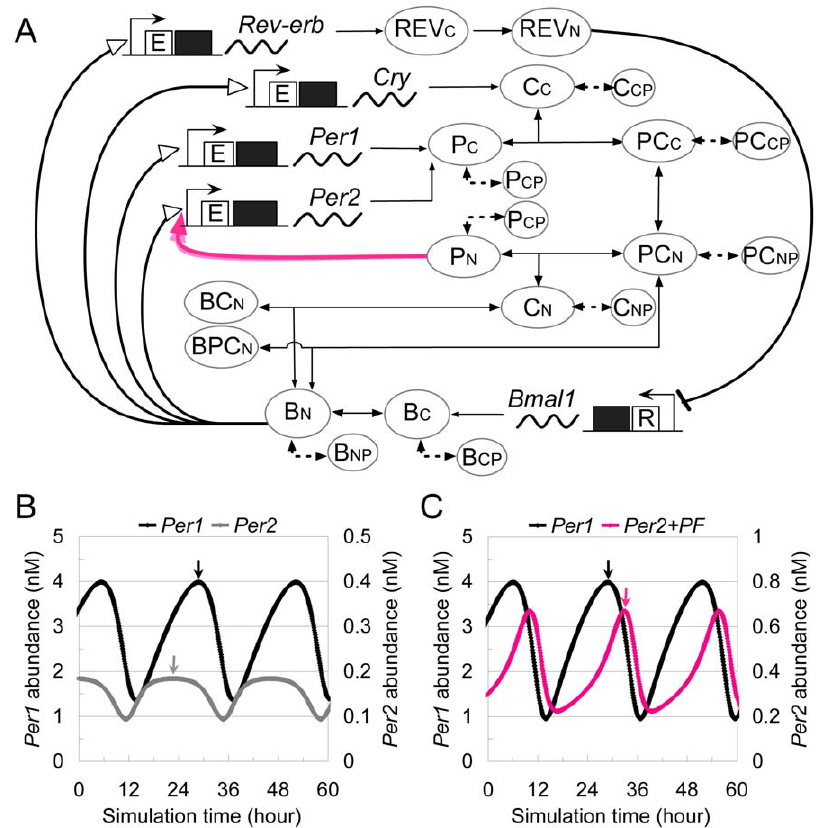
Figure 4. A novel model to reproduce the expression phase difference between Per1 and Per2 . (A) A new model hypothesized Per2 positive feedback regulation. Nuclear PER1/2 acts as a positive regulator of Per2 mRNA transcription. Details are described in Text S1 and parameters are indicated in Table S1. (B) A simulation result of the model without the positive feedback regulation ( k AP2 =0 h 2 1 ). This model simulated the circadian oscillations in 23.5-hour periods but did not reproduce the oscillation phase of Per1 preceding that of Per2 when applying the measured ratios of the synthesis and degradation rates of Per1 and Per2 . The oscillation phase of Per1 lagged behind than that of Per2 by 6.1 hours (6.25 hours in CT). (C) A simulation result of the model with the rate coefficient of positive feedback regulation k AP2 =2.4 h 2 1 . This model simulated the circadian oscillations in 22.8-hour period and the expression phase of Per2 mRNA was delayed from that of Per1 by 4.0 hours. Arrows indicate expression peaks. After 1000 hours simulation, the first peak of Per1 mRNA was set to simulation time 6.